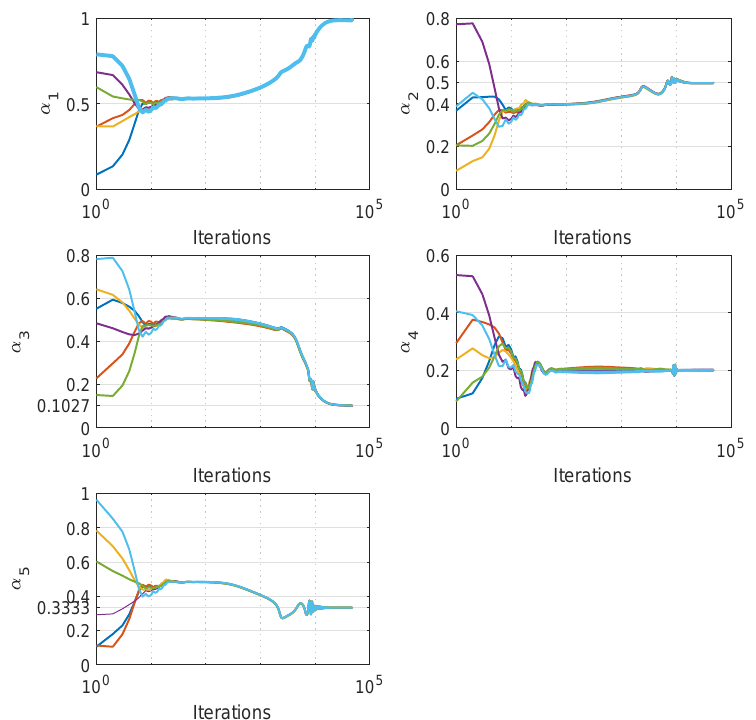
Figure 8. ααα t convergence trajectories implemented by the proposed